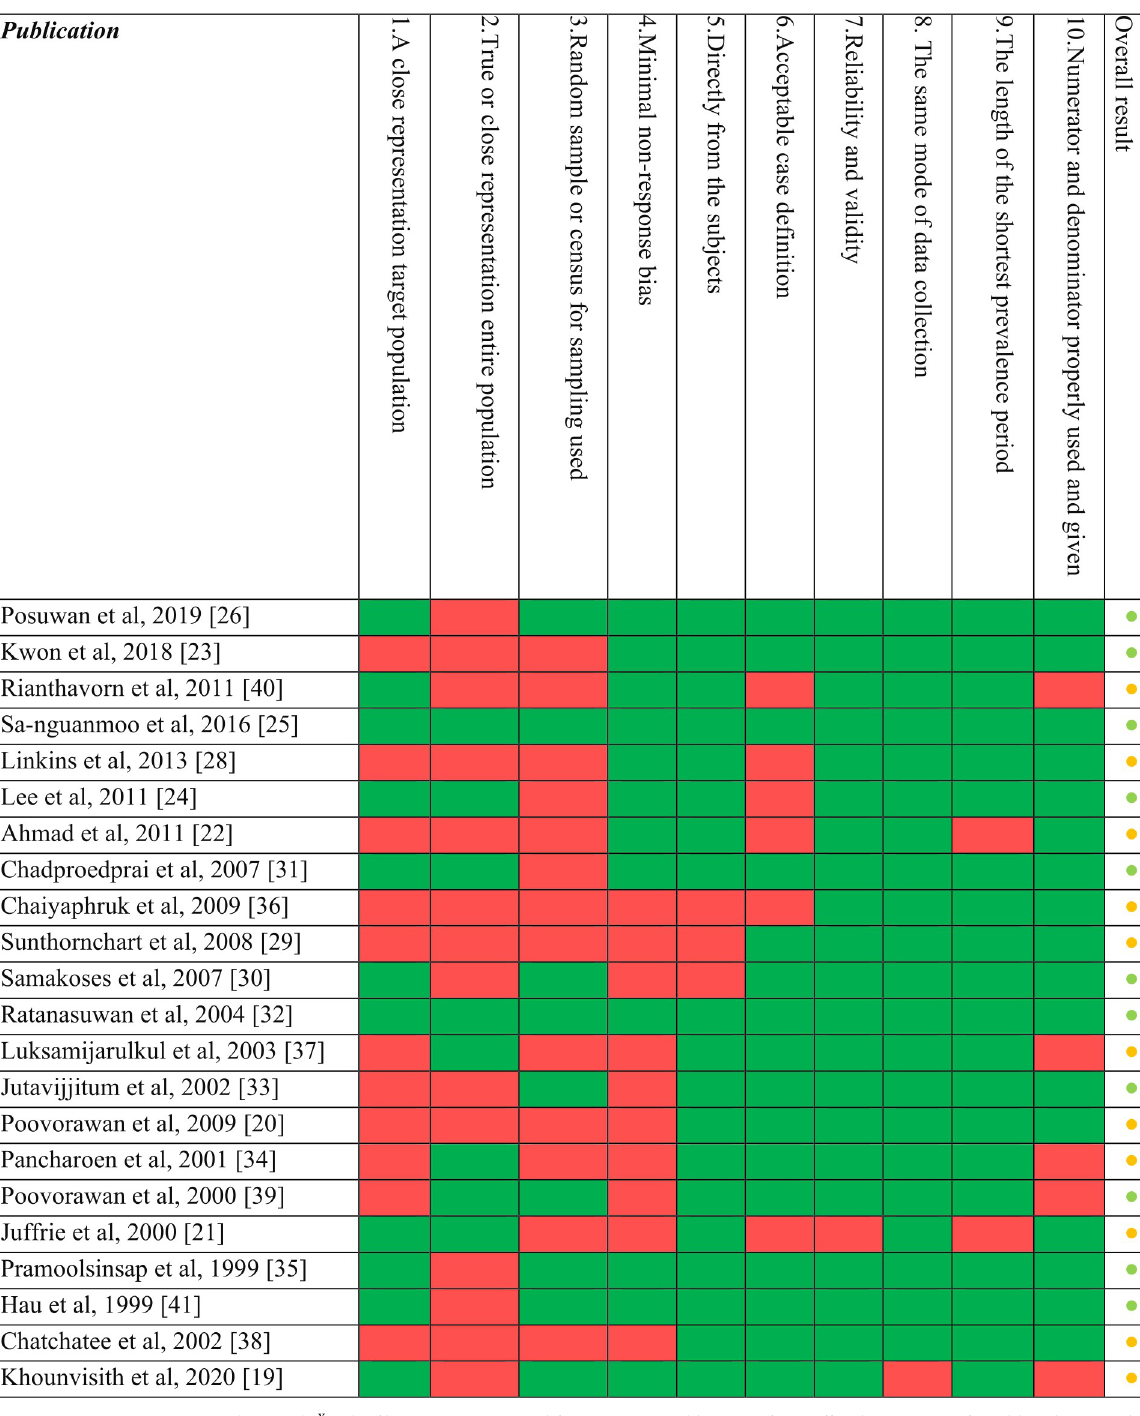
Fig 4. Risk of bias assessment (n = 22¥). ¥ Risk of bias was not assessed for reports or publications from official Ministries of Health websites and outbreak specific studies. Color coding: Per item result: green = Yes; red = No. Overall result: green, and amber dots correspond to low and medium risk of bias,